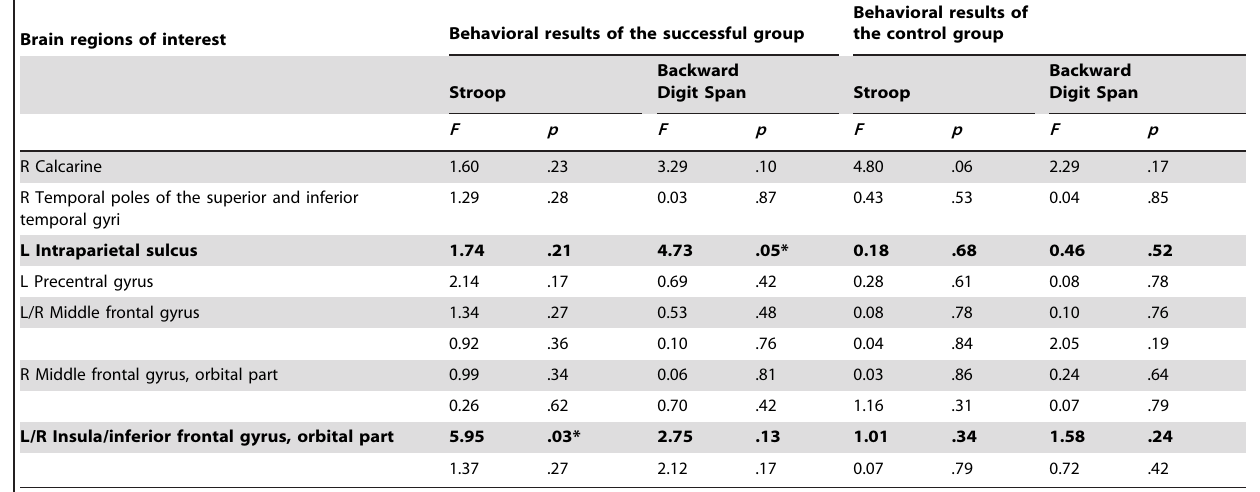
Brain regions of